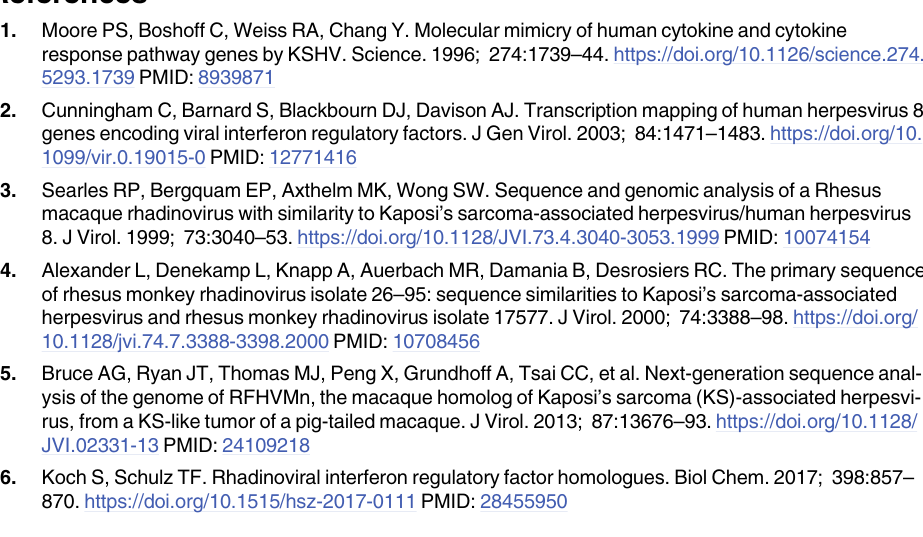
S1 Chart Data. Compiled primary and processed data underlying charts presented in the